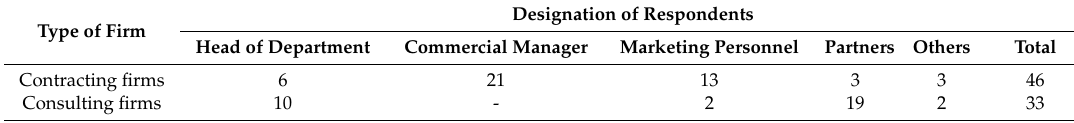
Table 1. Cross-section of the